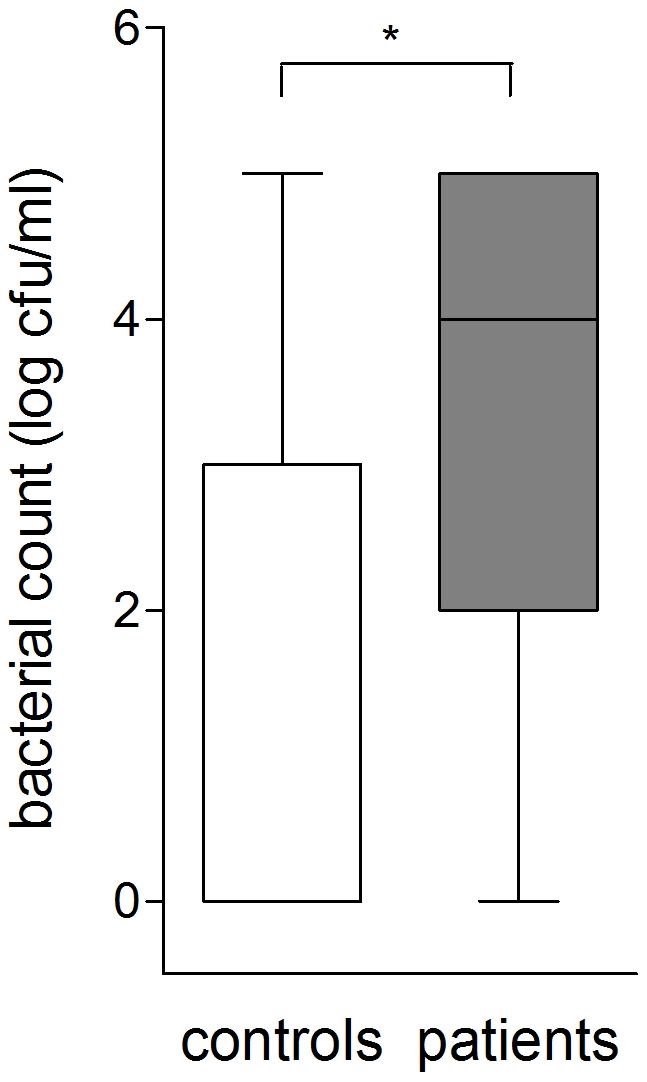
Comparison of granulocyte and bacterial count in the bronchoalveolar lavage fluid of controls, number of controls: n = 14, significance levels were calculated using Mann- Whitney- U- Test (p<0,005).